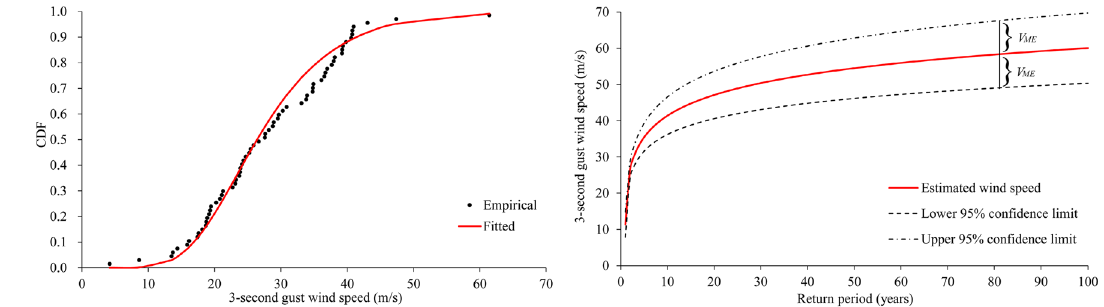
Fig. 7 Cumulative distribution functions and wind frequency for Meilan station in Hainan Province,